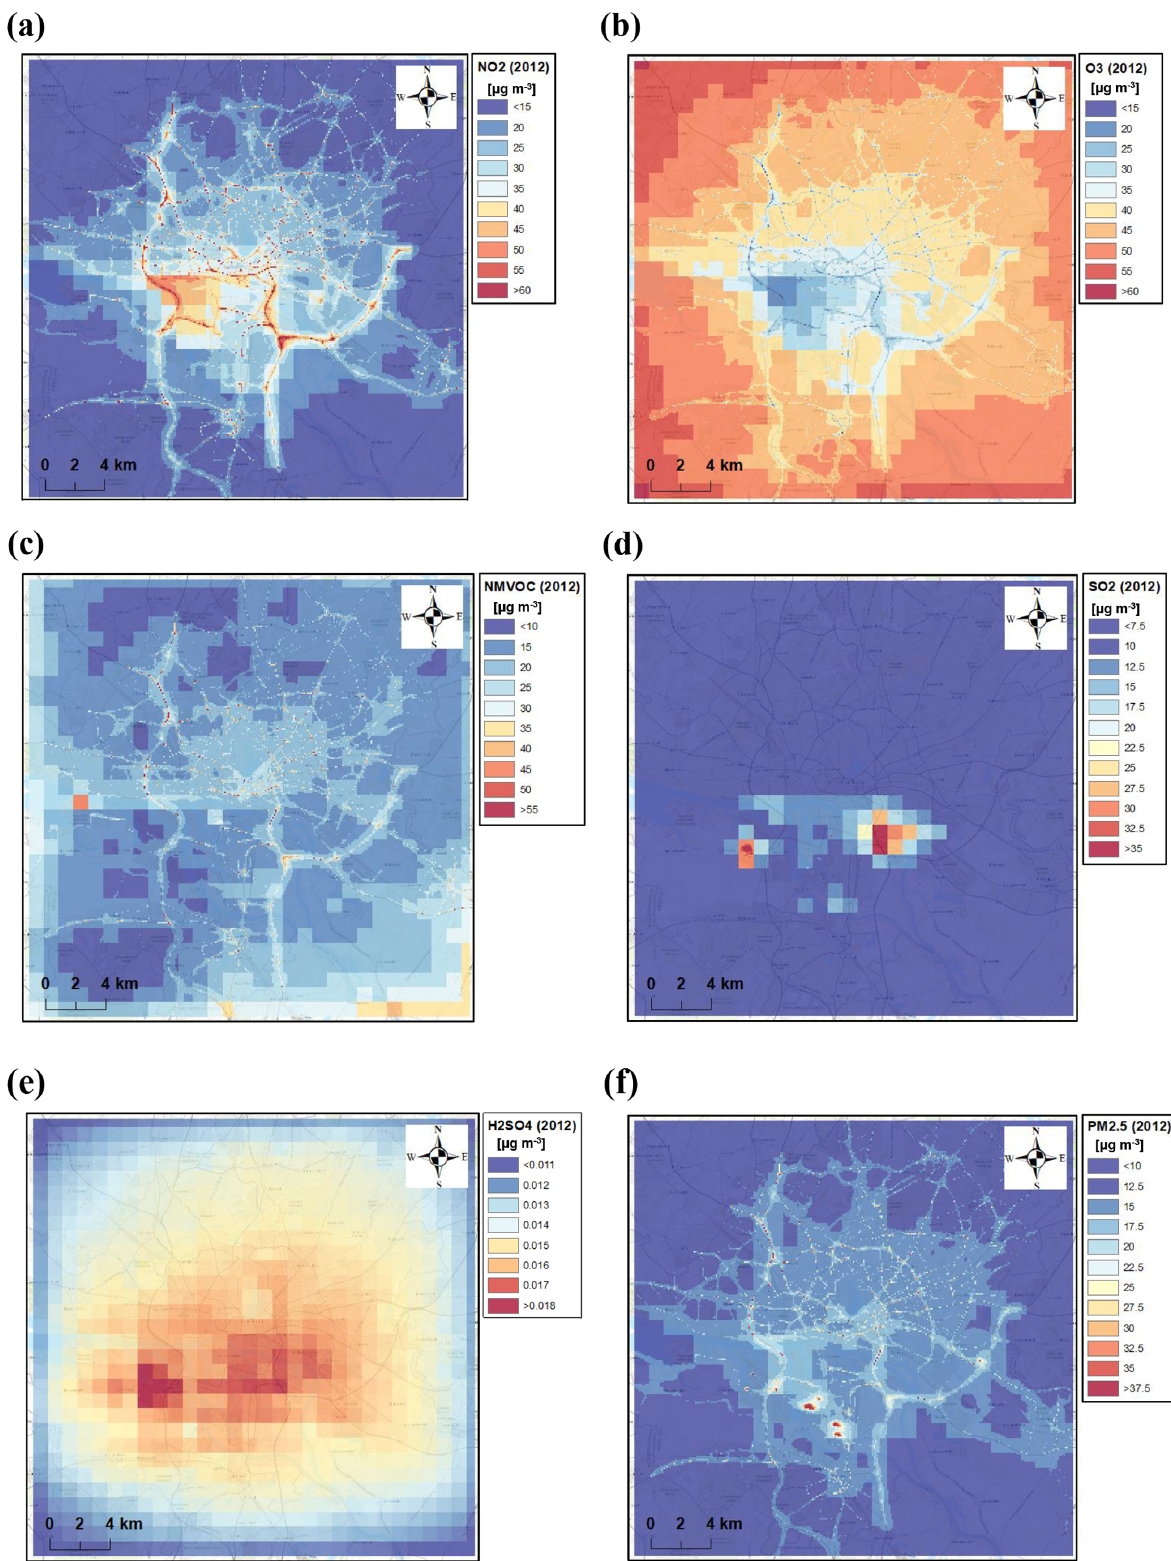
Figure 9. Spatial maps of the annual concentration average (µgm − 3 ) for Hamburg from the EPISODE–CityChem model simulation output for the receptor grid (100 × 100m 2 ): (a) NO 2 , (b) O 3 , (c) total NMVOC, (d) SO 2 , (e) H 2 SO 4 and (f) PM 2 . 5 . Maps are created using ESRI ® ArcMap ™ , with an overlay on a topographic base map showing the network of main roads as grey